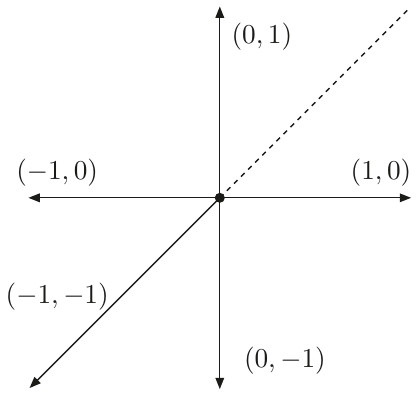
Figure 4 . A toric fan for dP 2 can be obtained by removing the edge (1 , 1) from the toric fan for dP 3